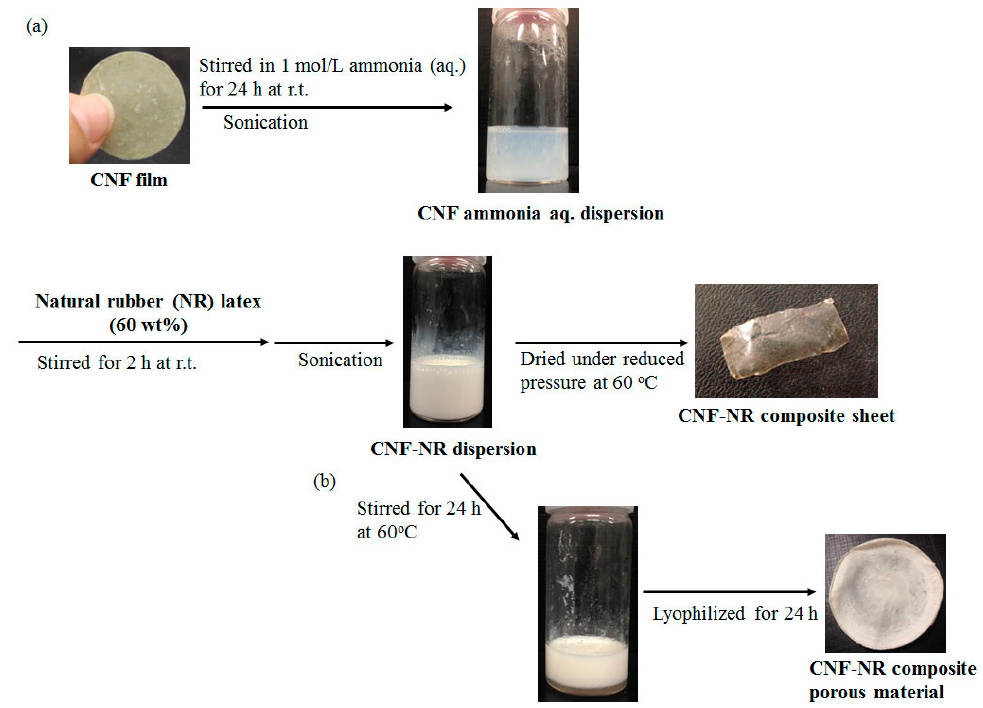
Figure 2. ( a ) Preparation of self-assembled CNF-NR composite sheet; and ( b ) self-assembled CNF-NR composite porous material.